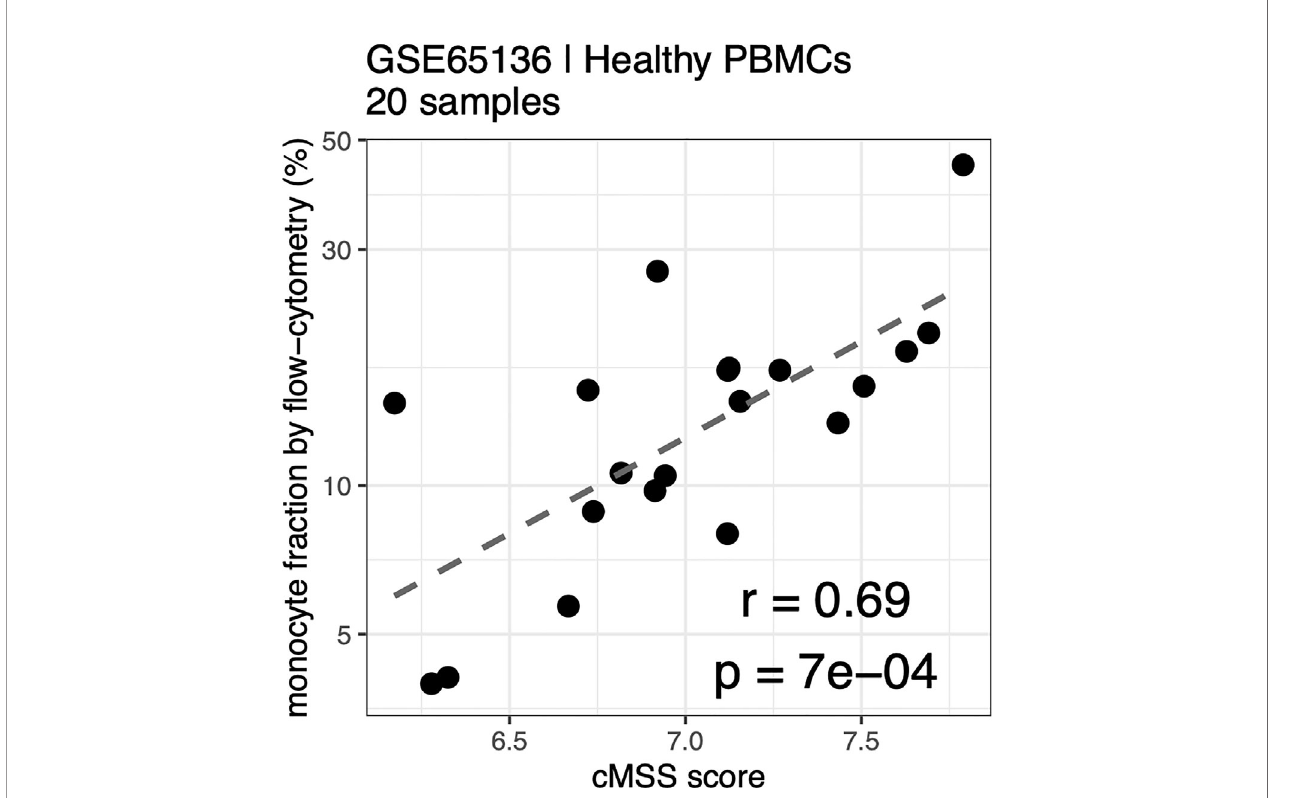
FIGURE 6 | Monocyte signature quanti fi es monocytes in PBMC by fl ow-cytometry: Correlation between cMSS score and measured monocyte fraction by fl ow- cytometry from healthy PBC<s measured in GSE65136. Y-axis indicates measured cellular proportions by fl ow-cytometry, X-axis indicates cMSS score for the same samples. Correlation and signi fi cance are computed by calculating Pearson ’ s correlation coef fi